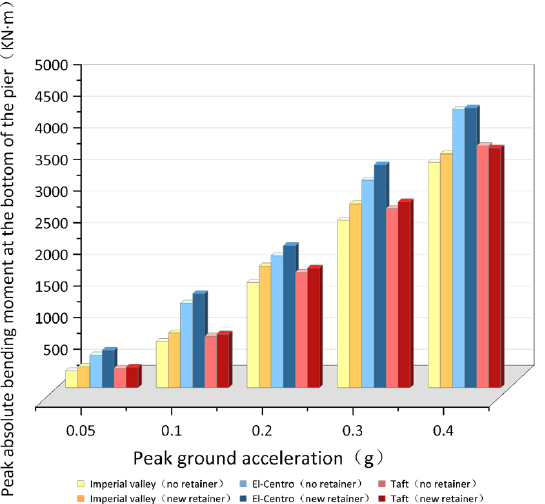
Figure 24. Contradistinction of the peak absolute value of bending moment at pier bottom.